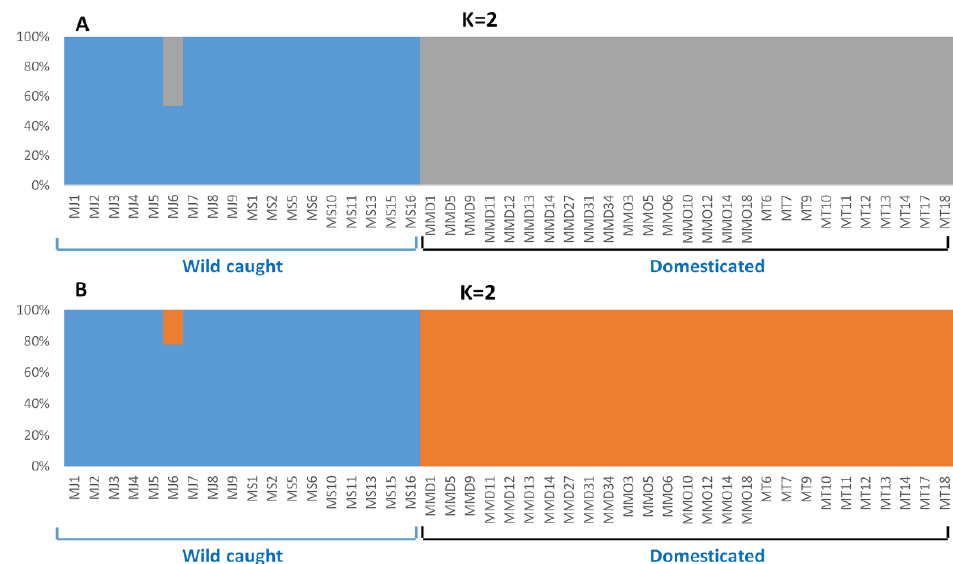
Figure 5. Bayesian STRUCTURE bar plot for all SNP loci dataset ( A ) and the putatively adaptive panel of SNP loci dataset identified by pcadapt approaches ( B ) of five broodstock populations of Penaeus monodon in the Indo-Pacific region. Each color represents the proportion of inferred ancestry from K ancestral populations and each bar represents an individual sample. Based on the delta K statistic, the best supported number of a posteriori genetic clusters was K = 2 for the standard admixture model. Here, MJ indicate samples from Shizuoka, Japan (wild); MS indicate samples from Setiu Wetland, Malaysia (wild); MMD indicates samples from Mahajamba, Madagascar (Domesticated); MMO indicates samples from Hawaii, HI, USA (Domesticated); MT indicates samples from Petchaburi Province, Thailand (Domesticated). The numeric number next to the sample name abbreviation indicates the respective individual tag number during collection.